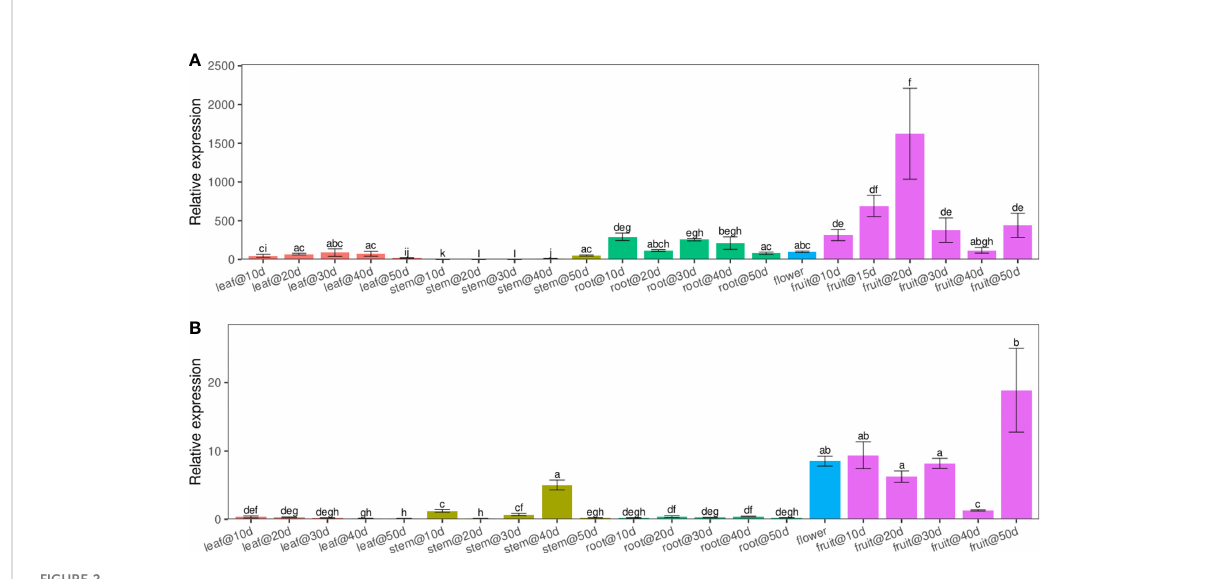
FIGURE 2 LuWRI1a and LuWRI1b pro fi le expressions of fl ax plant. By qRT-PCR, we were able to determine the expressions pro fi ling of LuWRI1a and LuWRI1b in the primary fl ax organs. R1 – R5, root in the 10th to 50th days after fl owering; S1 – S5, stem in the 10th to 50th days after fl owering; L1 – L5, leaves in the 10th to 50th days after fl owering; F, the fi rst three opened fl owers; 10D – 50D, developing seed stages. Error bars represent SD (n = 3). Student ′ s t-test was utilized. These identical letters revealed that there is not a statistical signi fi cance (P<